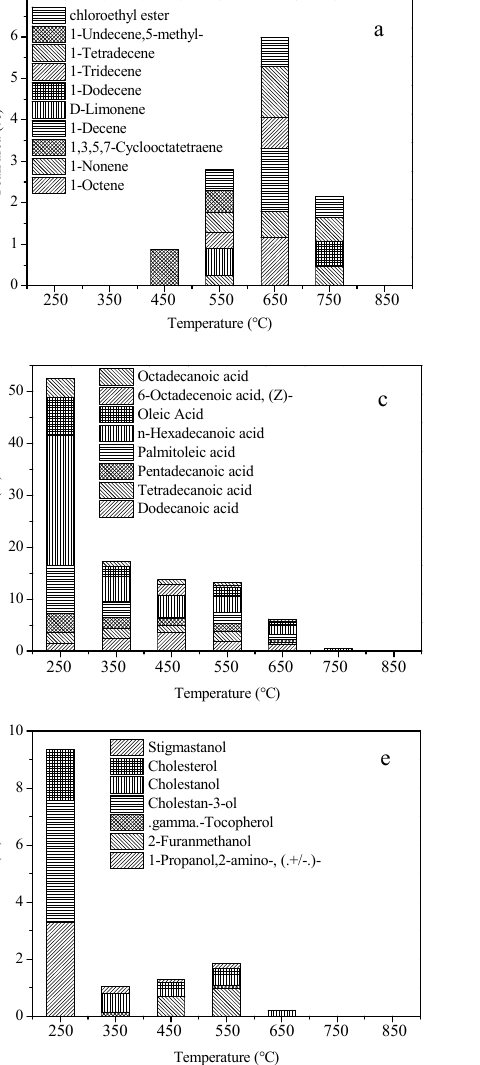
Figure 6. Distribution of compounds with carbon and oxygen-containing functional groups at different temperatures. (a) C=C ; (b) -C 6 H 5 ; (c) O-C=O ; (d) -CHO . (e) R-OH ; (f) Ar-OH .